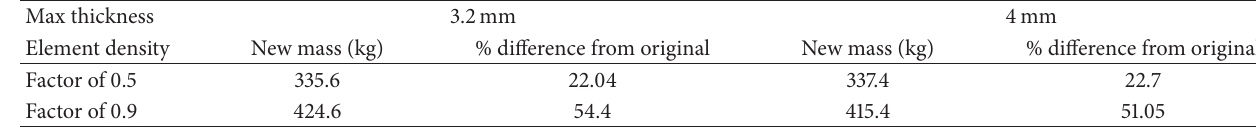
Table 5: Size optimization result.